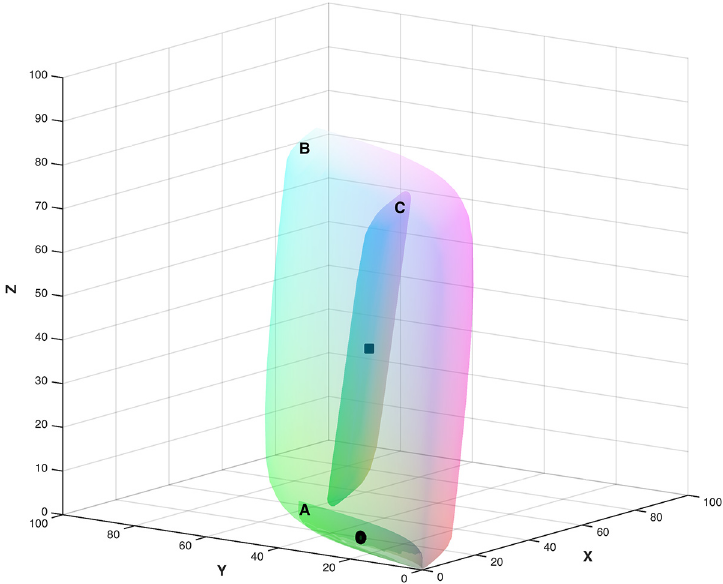
Fig 9. Label A indicates the object-colour solid under green (G) illumination. B indicates the object colour solid under the neutral (N) illumination. The black dot indicates flat grey under green (G). C indicates the metamer mismatch volume of the flat grey for a change in illumination from green (G) to neutral (N). The black square shows flat grey under the neutral (N)